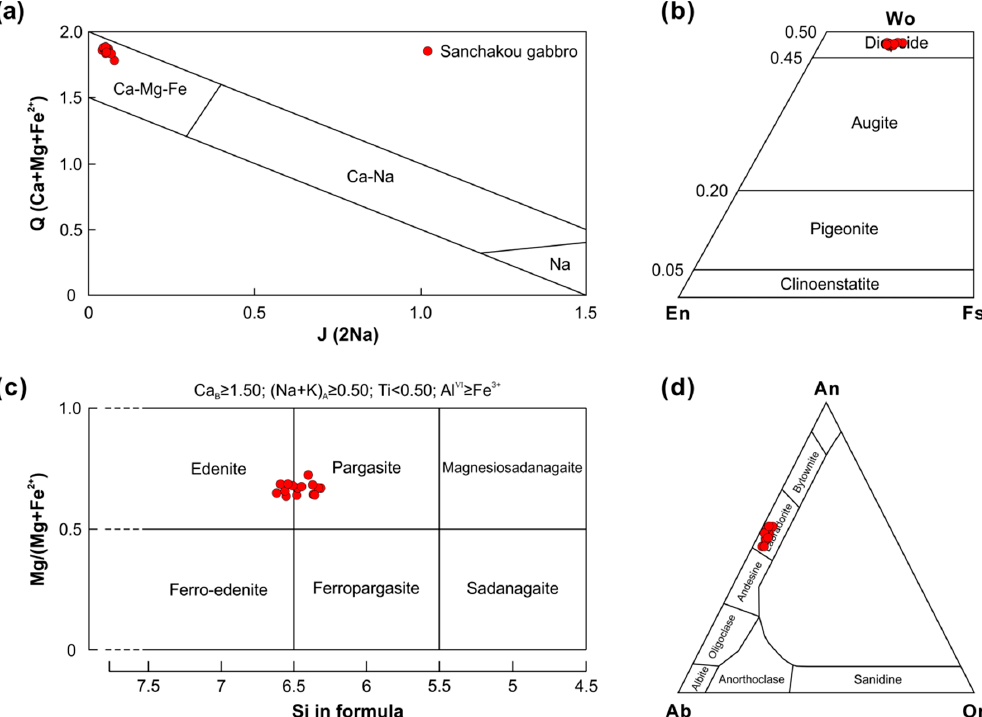
Figure 3. Mineral compositions of the Sanchakou gabbros from the Jining terrane. ( a ) The Q-J diagram of pyroxene according to the nomenclature of [71]; ( b ) The classification diagram of pyroxene according to the nomenclature of [71]; ( c ) The classification diagram of amphibole according to the nomenclature of [72]; ( d ) The classification diagram of feldspar according to the nomenclature of [73]. Mineral abbreviations: Ab, albite; An, anorthite; En, enstatite; Fs, ferrosilite; Or, potassium feldspar; Wo, wollastonite.